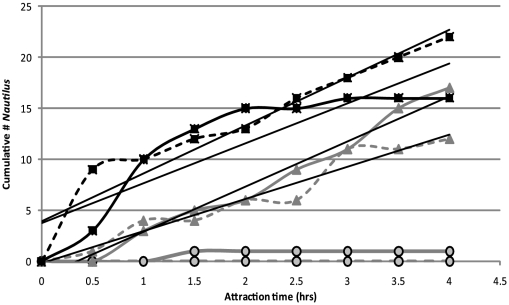
Baited Remote Underwater Video System Nautilus attraction times.The cumulative number of Nautilus attracted to the baited trap over time is shown to produce a linear curve with a mean attraction rate of 4.03 hr−1 for the red (grey triangles) and blue/white/red (black squares) lighted traps. Traps with blue light only (black outlined circles), showed almost no attraction. Replicated results for each light combination are shown.